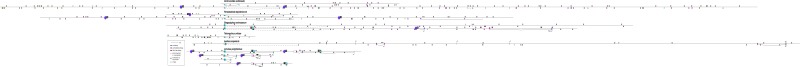
Some Chelicerates contain similar motifs (16, 17) near the duplicated pb/Hox3 genes.Where duplicated, paralogs are represented on separate lines.